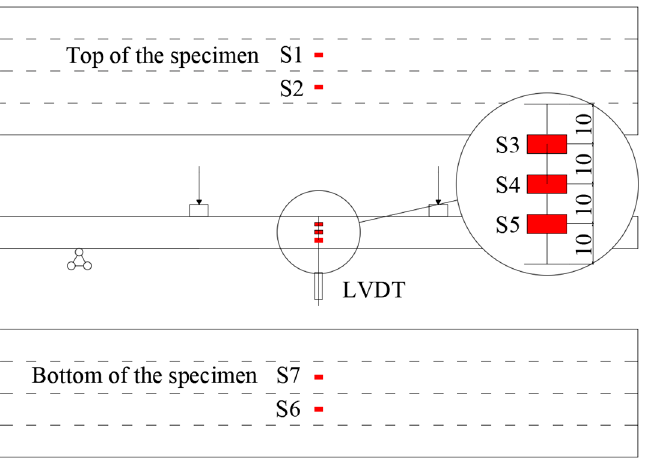
Figure 4. Layout of the points for the monitoring of strain (S1, S2, S3, S4, S5, S6, S7) and deflection (LVDT).